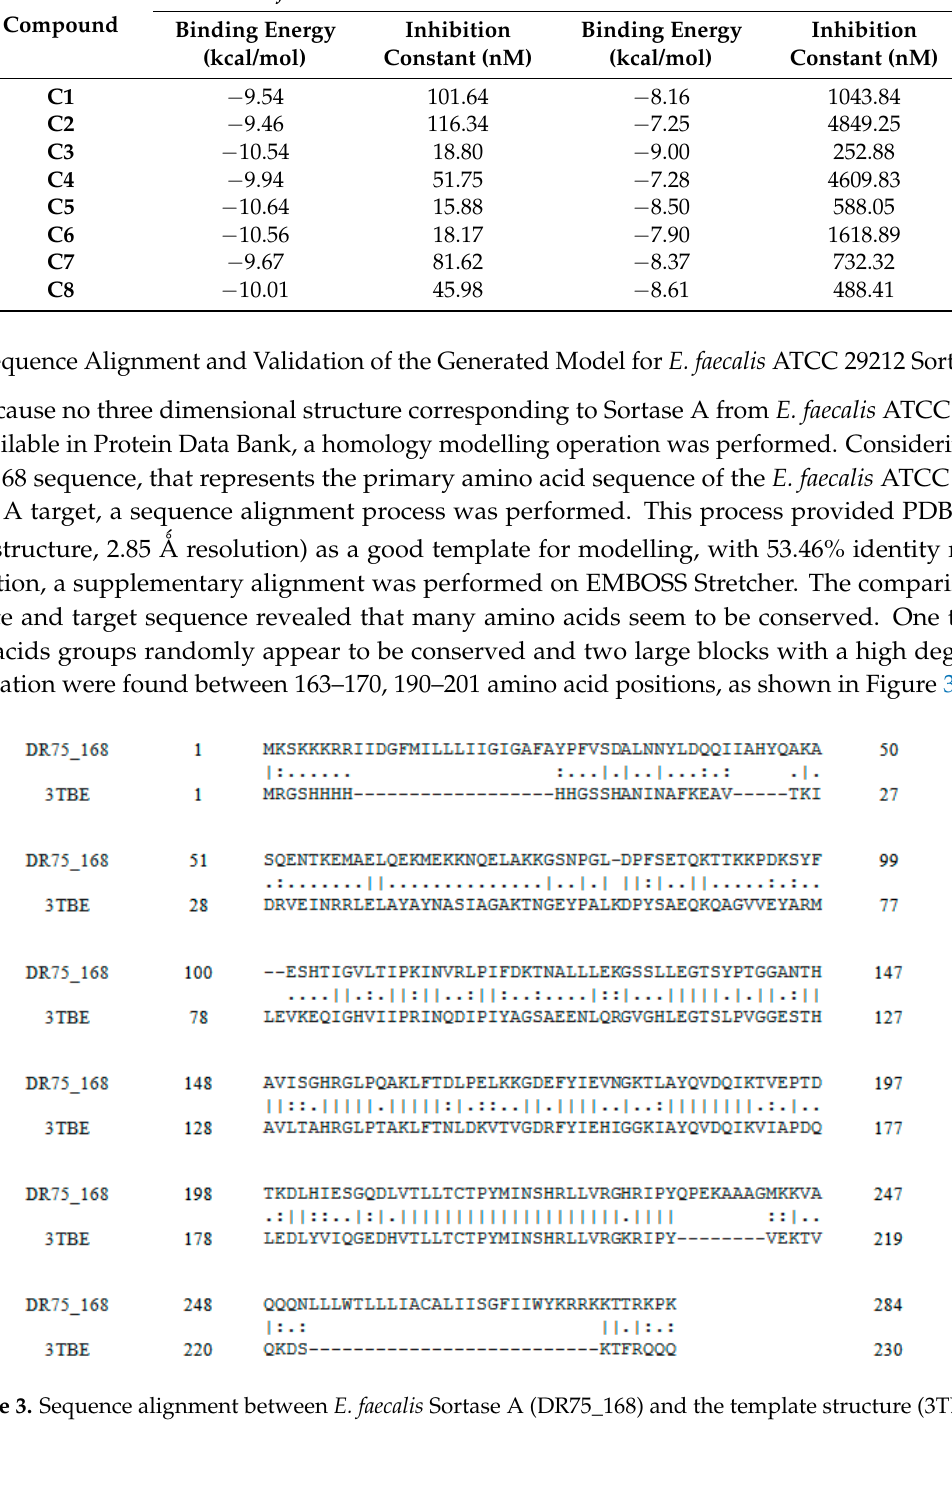
Table 4. Binding energies and Inhibition constants for the C1 – 8 —Sortase A complexes.